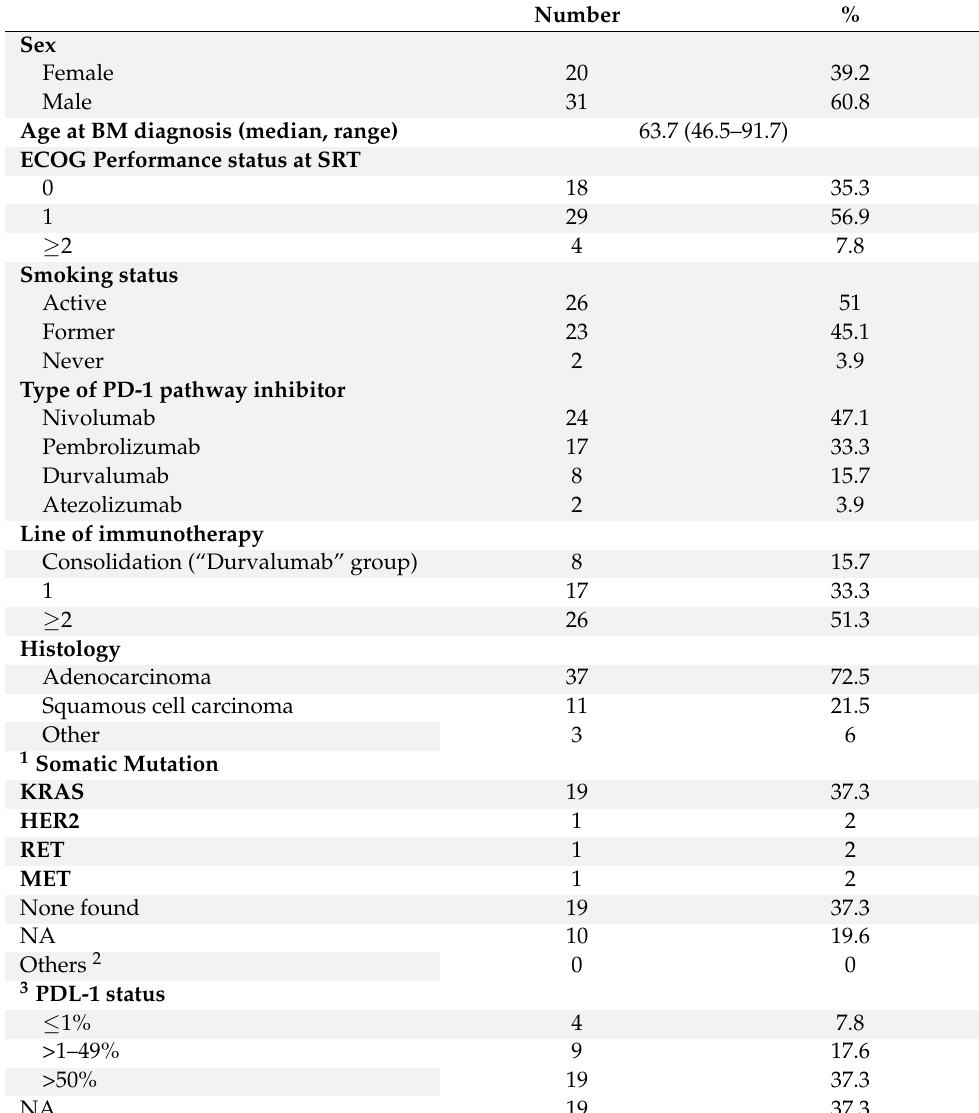
Table 1. Patient characteristics ( n =